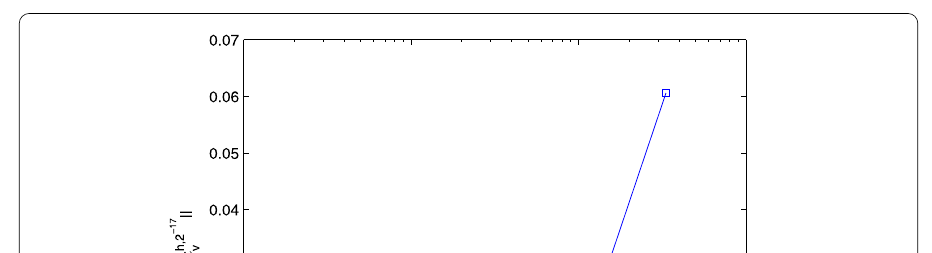
Figure 6 The error function | ε